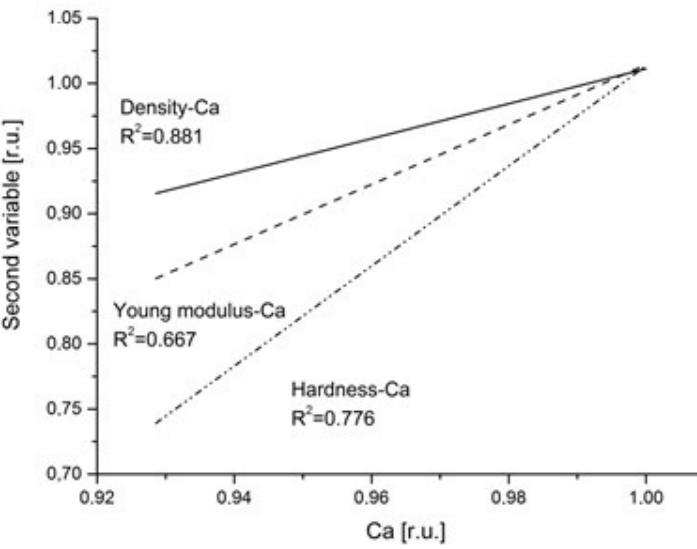
Figure 3. Comparison of the linear fits to the correlation relationships between relative values of density (adopted from [46]) and Ca (solid line); Young modulus and Ca (dotted line); hardness and Ca (dot-drop line)—adopted from [44,45]. Correlation coefficients are cited.